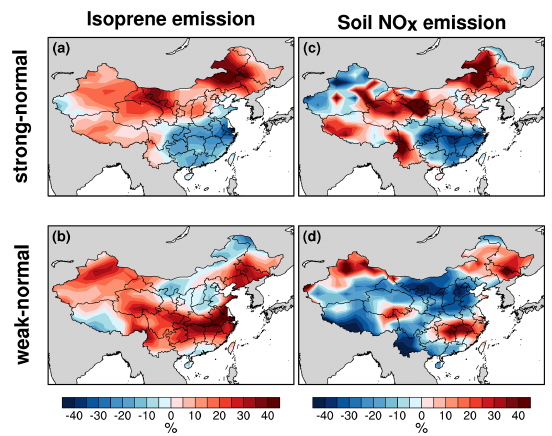
Figure 5. The changes in isoprene (a proxy of biogenic emissions) and soil NO x emissions in the GEOS-Chem model. Panels (a) and (c) show the relative differences (percentage) between strong and normal WPSH conditions, and (b) and (d) show those between weak and normal WPSH